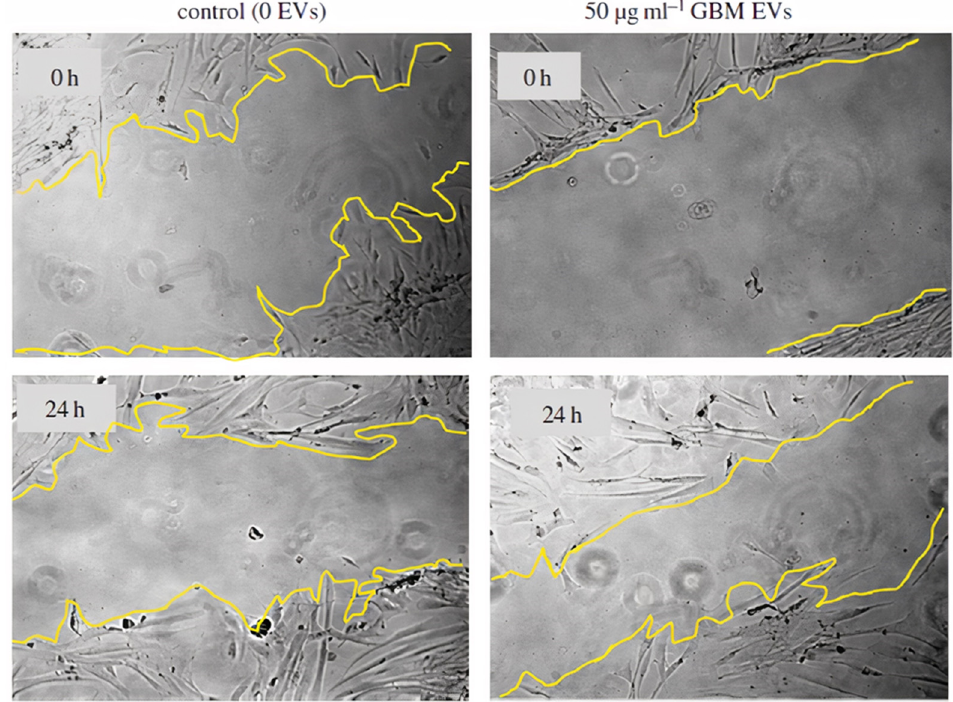
Figure 6. Glioblastoma EVs promote normal astrocyte migration [71]. Figure reproduced with permission from Royal Society.